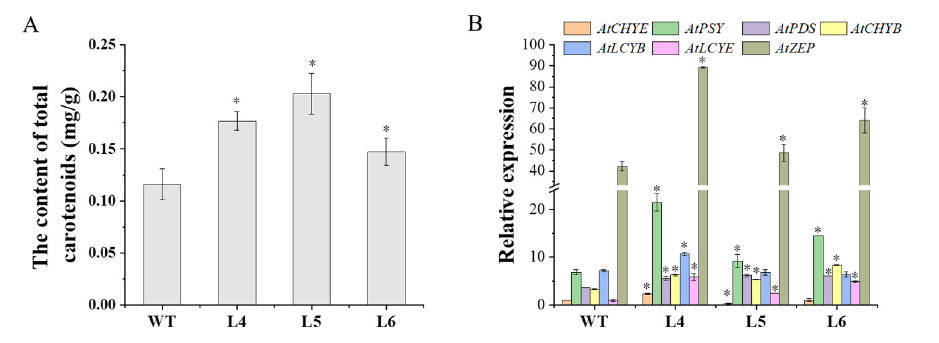
Figure 6. Total carotenoid content and transcript levels of the carotenoid biosynthesis genes in the rosette leaves of transgenic Arabidopsis and WT plants under irrigation with 200 mM NaCl for 7 days: ( A ) total carotenoids content, ( B ) relative expression of carotenoid biosynthesis genes. AtActin was used as an internal control. Expression of AtCHYE in WT was used as the calibration. Significant difference in gene expression between WT and transgenic lines (L4, L5, and L6) at * p < 0.05 by Student’s t -test.